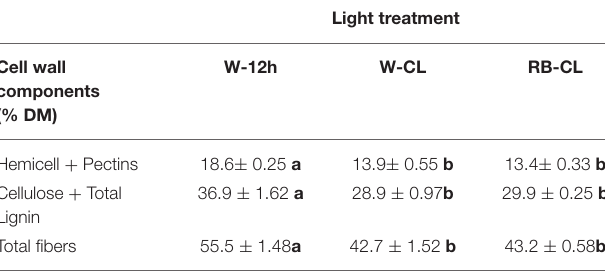
TABLE 4B | Cell wall component (% dry matter) content in the leaves of Eruca vesicaria (L.) Cav. grown under three different light treatment conditions. Light treatment